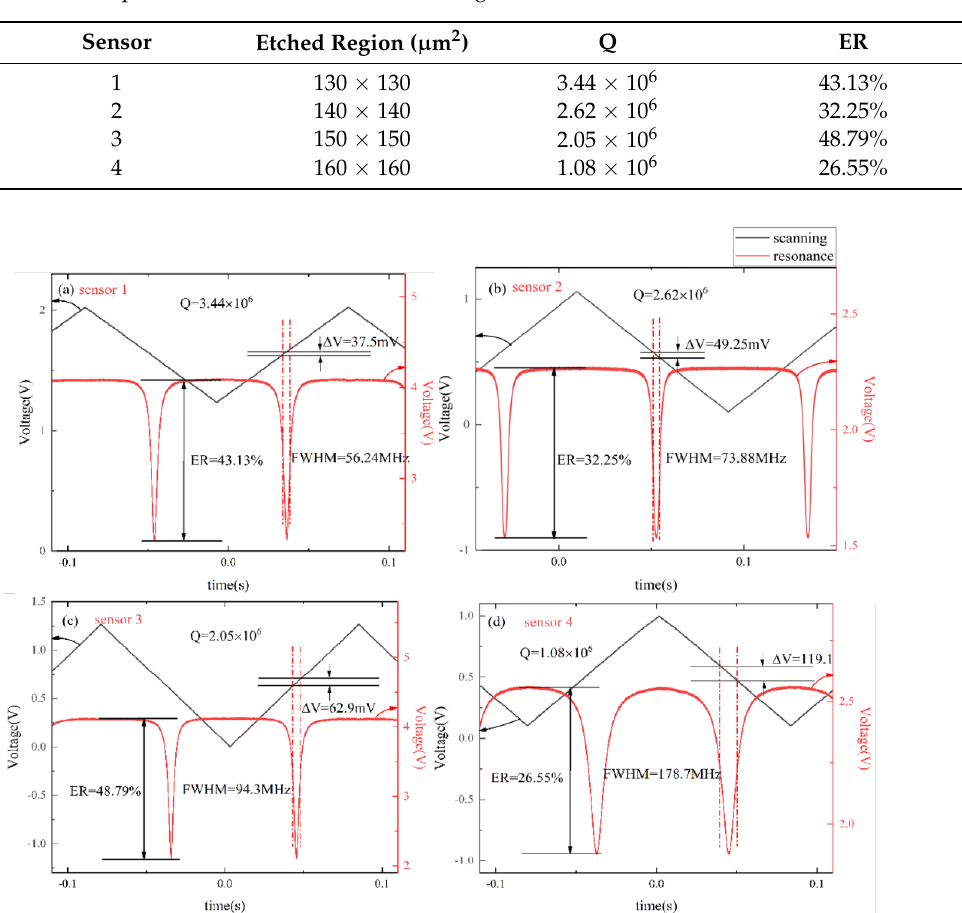
Table 1. The parameters of the manufactured ring resonators.